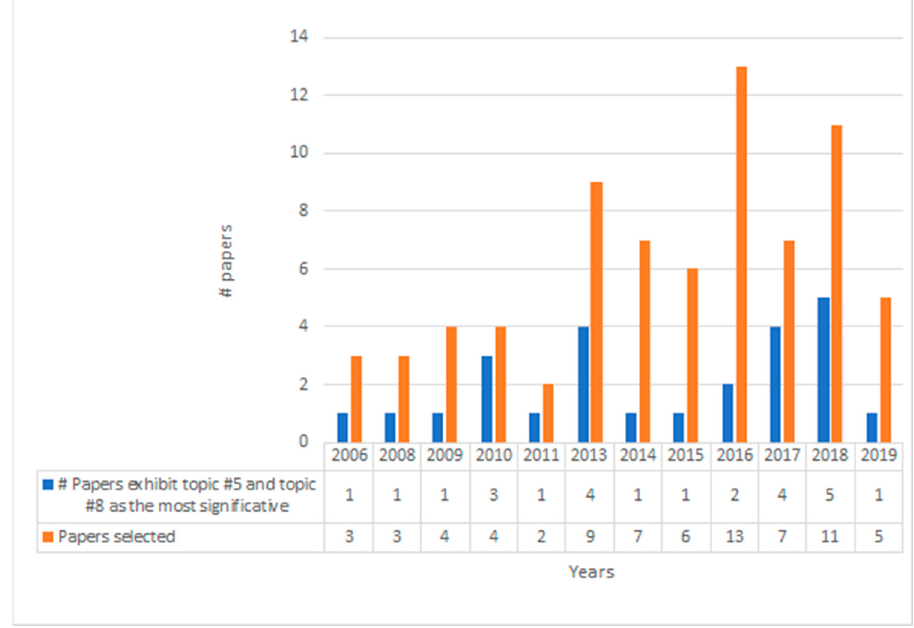
Figure 8. Distribution of the papers belonging to Topic #5 and Topic #8 over the years with respect to the total number of papers.